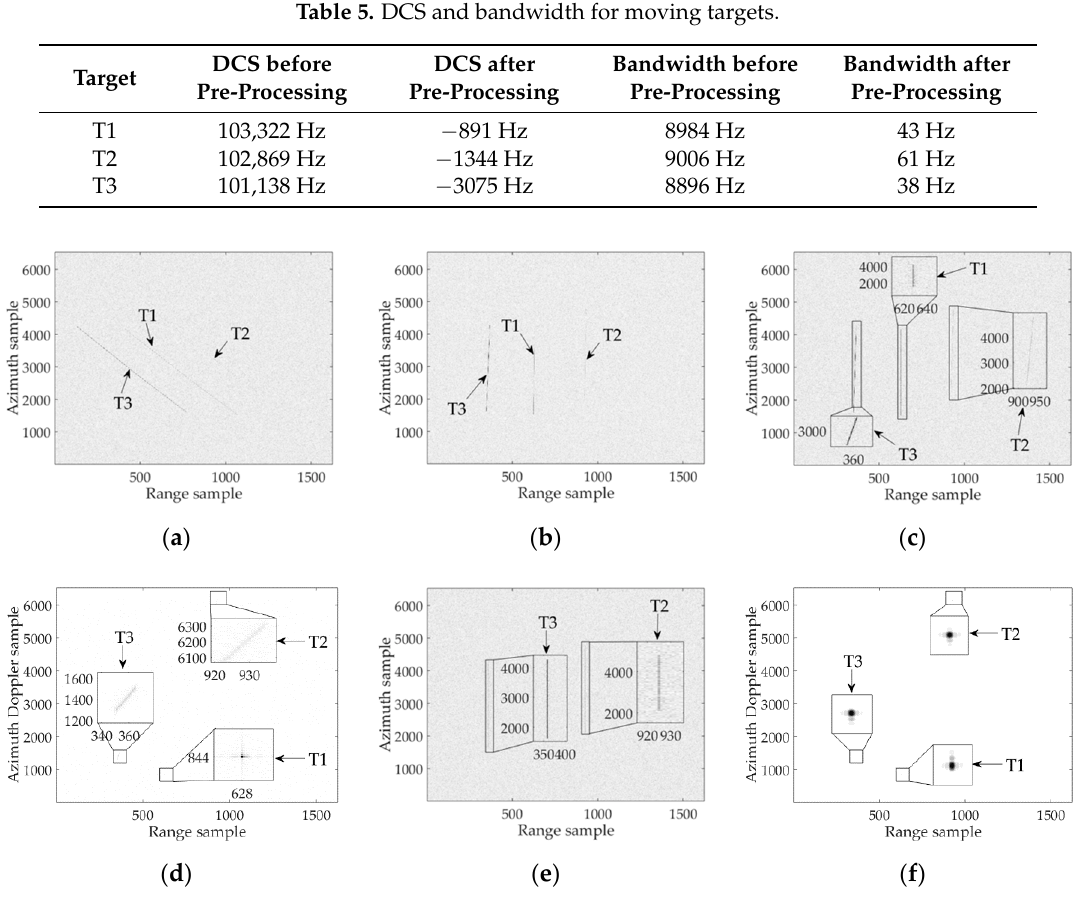
Figure 15. Simulation results for multiple target imaging under curvilinear trajectory condition: ( a ) range compressed signal; ( b ) pre-processing result; ( c ) BM-KT result for T1; ( d ) imaging result for T1; ( e ) multiple target filter result for separating T1 and BM-KT result for T2 and T3; and ( f ) multiple target imaging result.